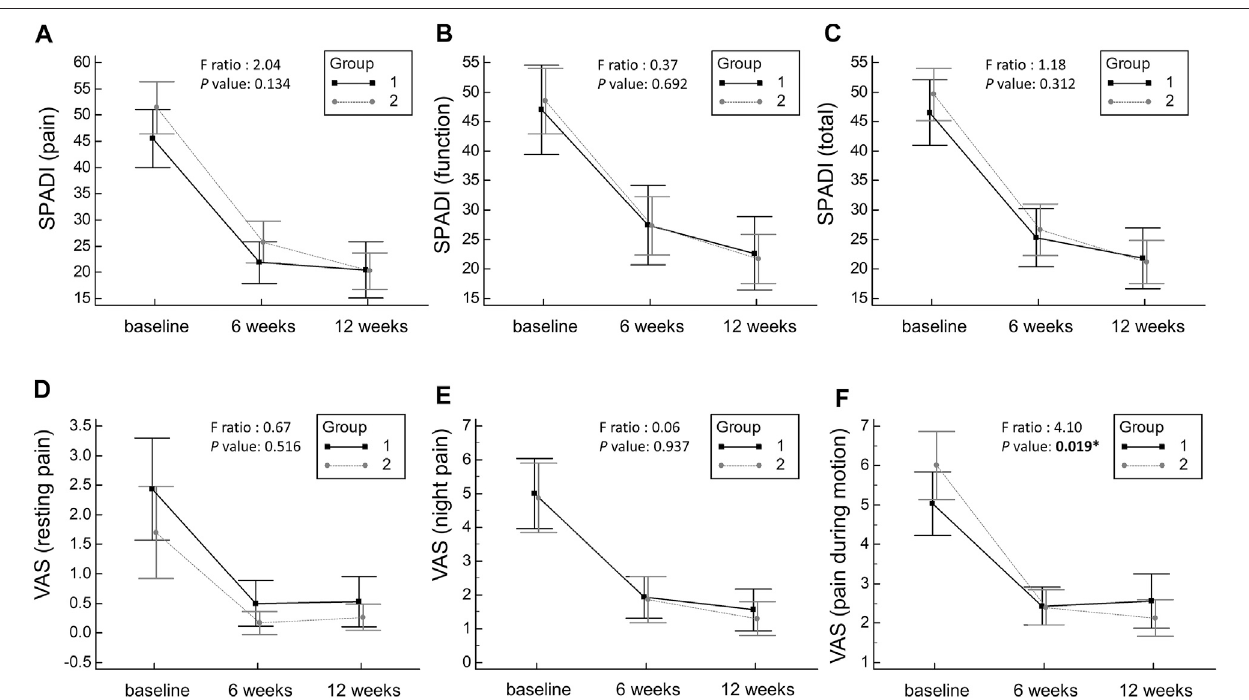
FIGURE 3 | Mean changes and the corresponding 95% con fi dence intervals pertaining to the pain domain of the SPADI scores (A) , the function domain of the SPADI score (B) , the total SPADI scores (C) , the VAS scores at rest (D) , the VAS scores at night (E) and the VAS scores during motion (F) . SPADI: Shoulder Pain and Disability Index; VAS, visual analogue scale. Group 1 indicates hydrodilatation though the posterior glenohumeral recess, whereas Group 2 indicates hydrodilatation through the rotator cuff interval.